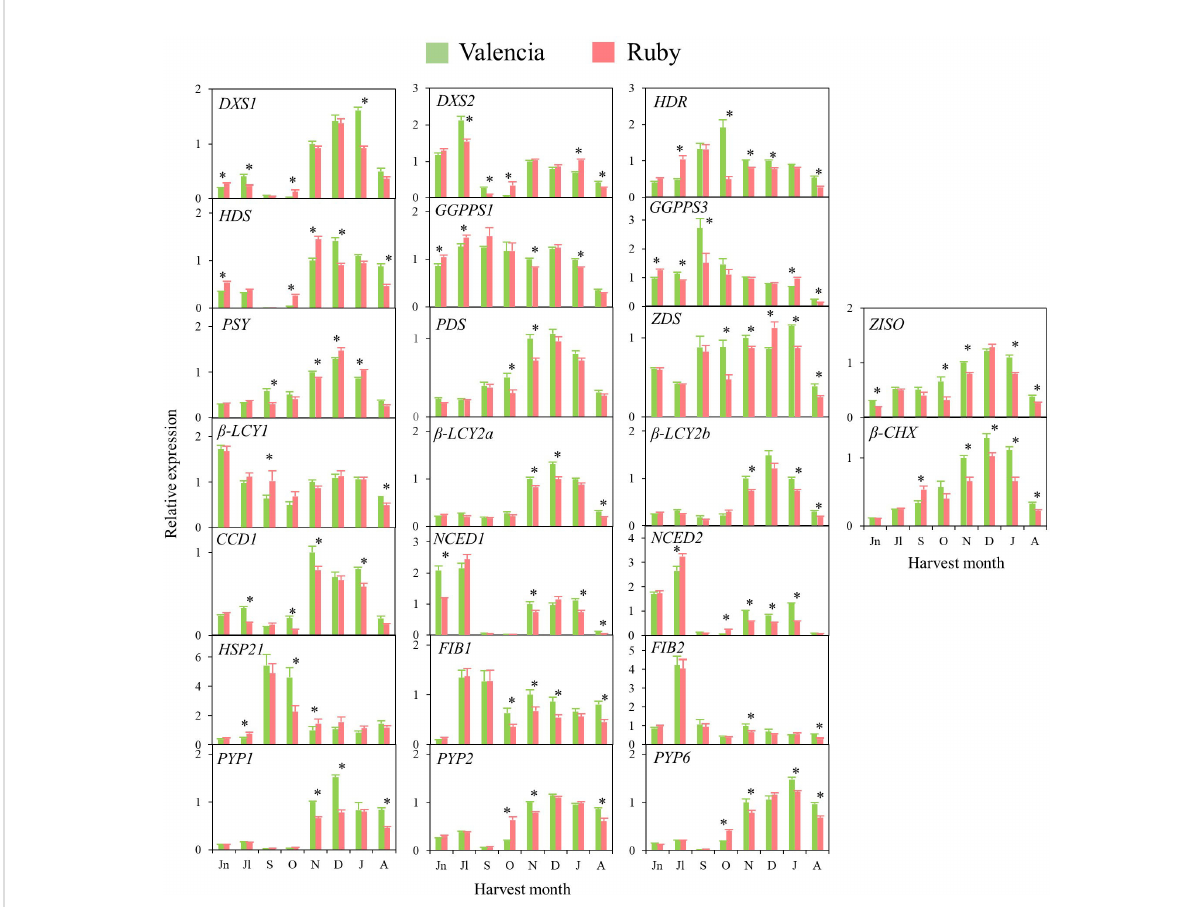
FIGURE 6 Relative expression levels of genes of carotenoids precursors ( DXS1 , DXS2 , HDR , HDS and GGPPS1 and GGPPS3 ), carotenes and xanthophylls biosynthesis ( PSY , PDS , Z-ISO , ZDS , b -LCY1 , b -LCY2a , b -LCY2b , b -CHX ), carotenoids catabolism ( CCD1b ), ABA biosynthesis ( NCED1 and NCED2 ), carotenoid-associated protein ( HSP21 , FIB1 and FIB2 ) and xanthophyll esteri fi cation ( PYP1, 2 and 6 ) in the pulp of Valencia and Ruby during fruit development and maturation. Jn, June; Jl, July; S, September; O, October; N, November; D, December; J, January; A, April. Data are the mean of three biological replicates ± SD. Asterisks indicate signi fi cant differences between Valencia and Ruby varieties by unpaired Student ’ s t-test (p <